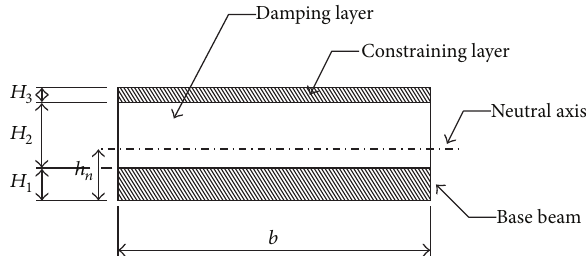
Figure 1: Cross section of a three-layer sandwich beam with a viscoelastic damping